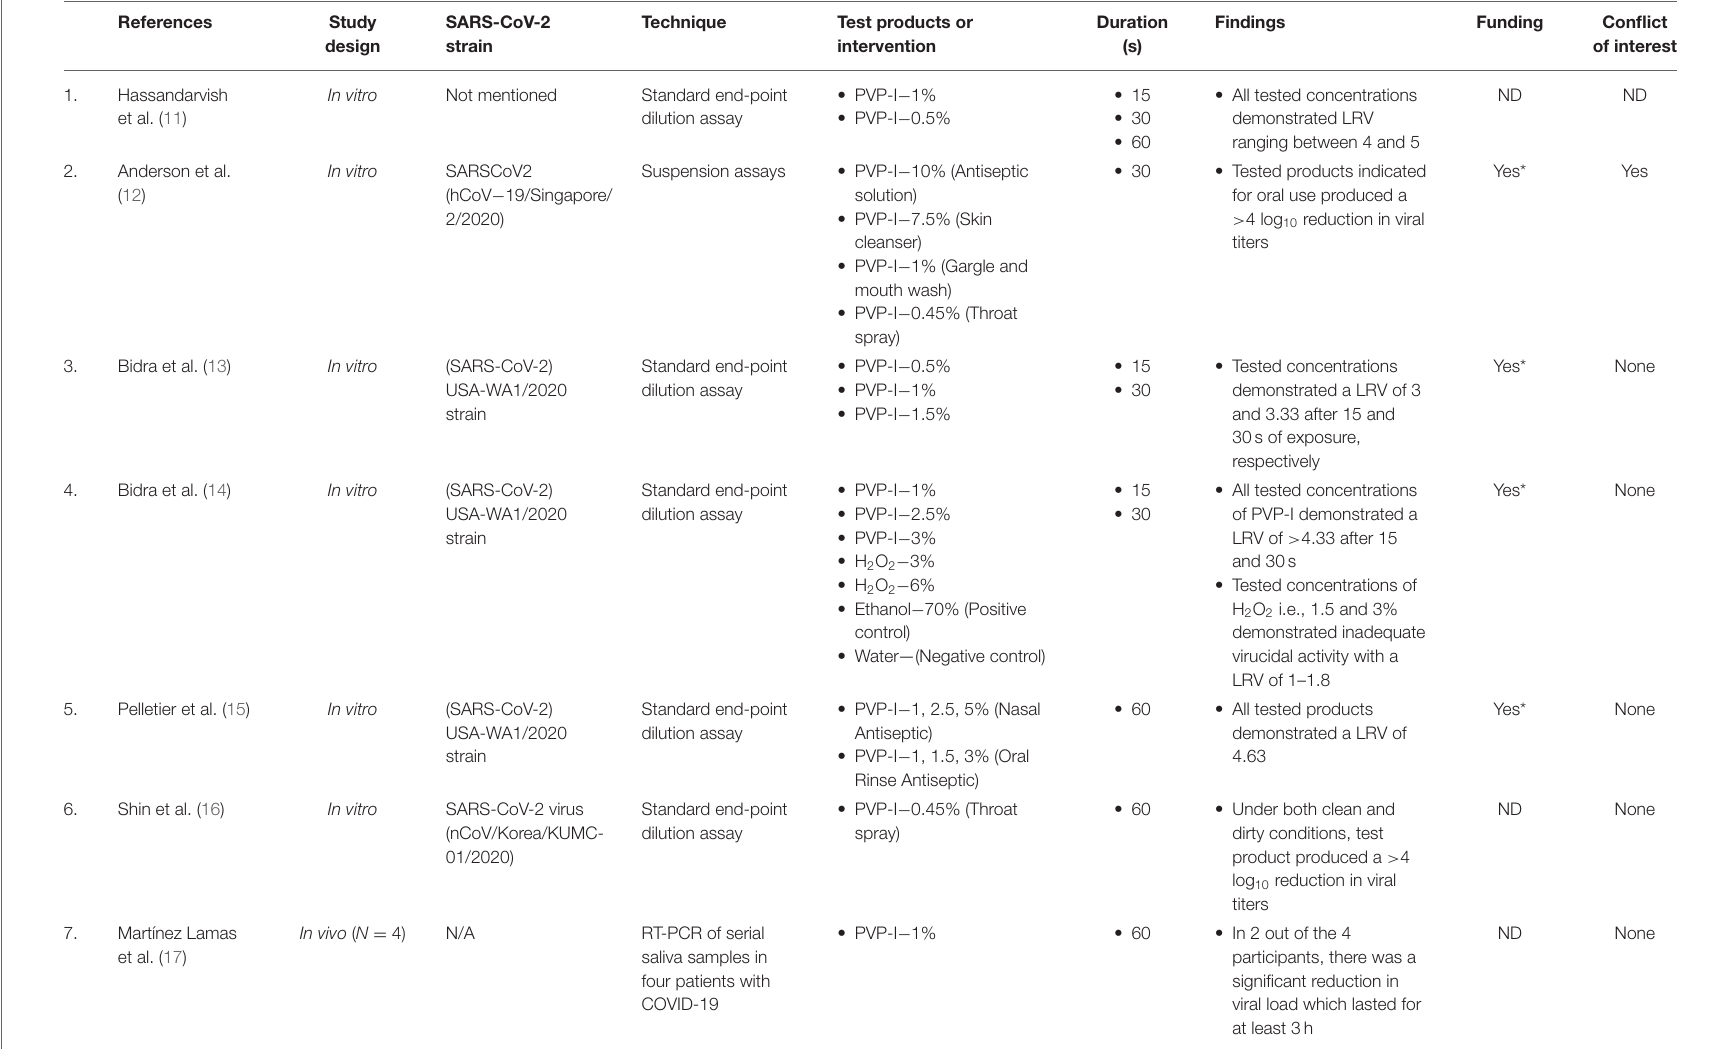
TABLE 1 | Study characteristics of included studies in the scoping